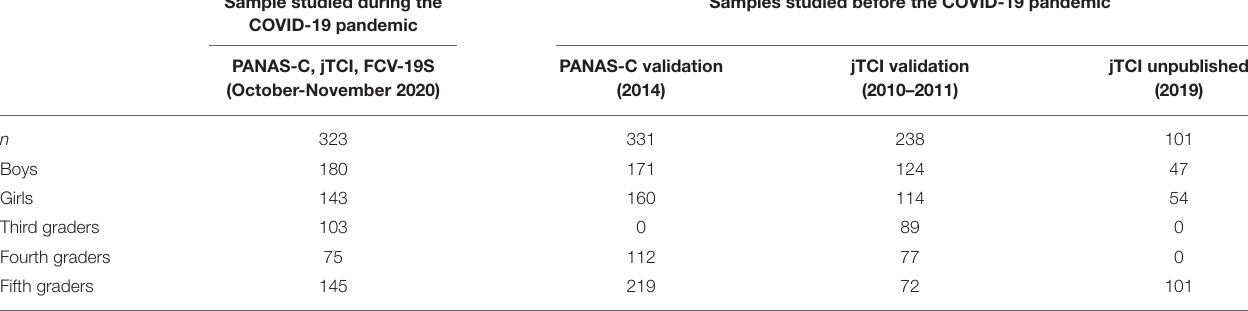
Samples studied before the COVID-19 pandemic